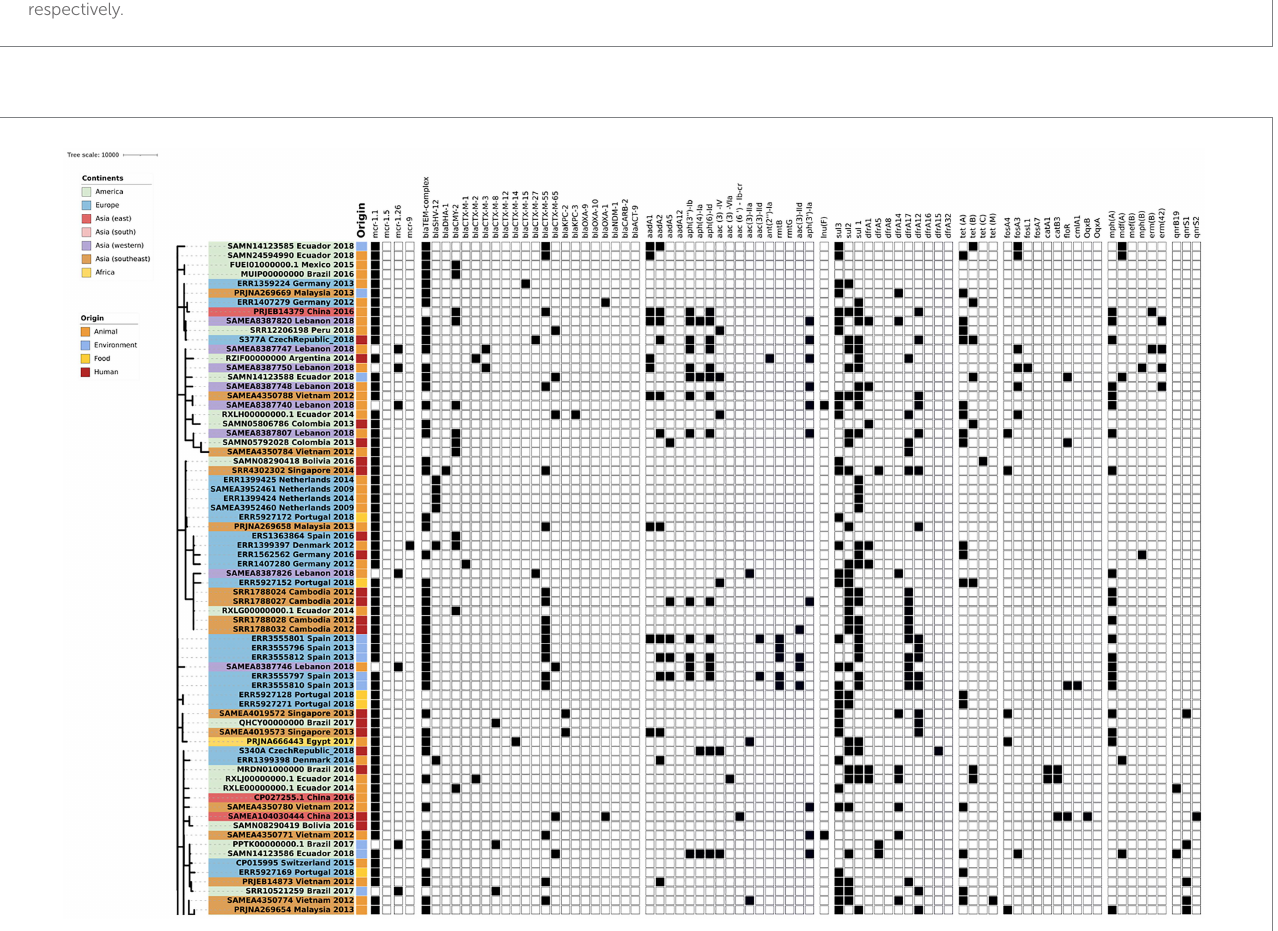
FIGURE 4 Antibiotic resistance genes content of the evaluated E. coli sequences (Part one). The source of the isolates is specified by different colors in the genomic cg-MLST tree branches. Squares indicate the presence (black) and absence (white) of antibiotic resistance